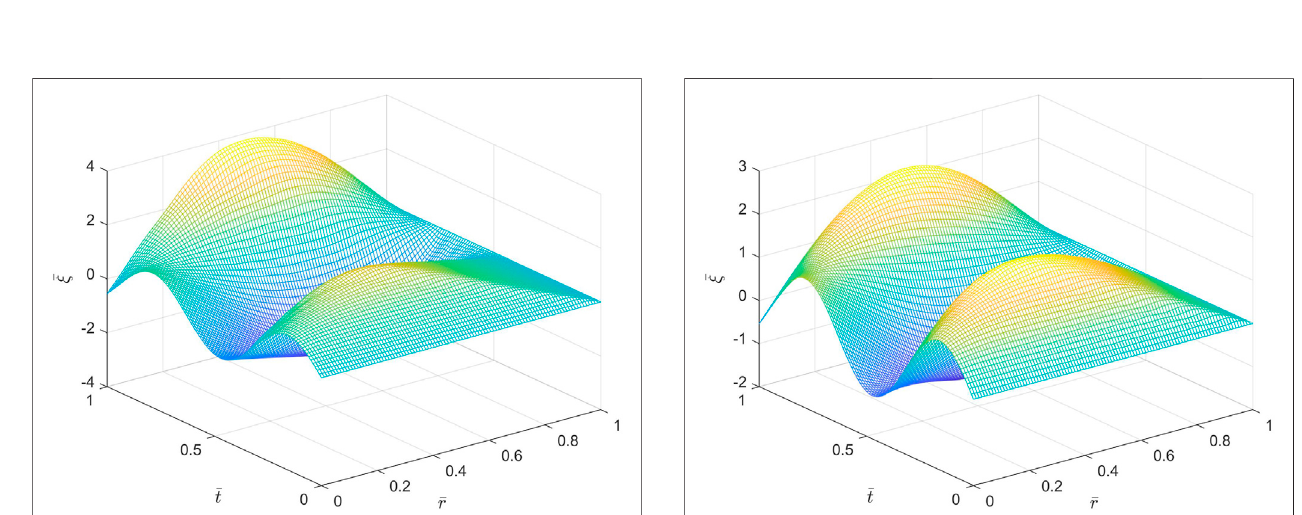
FIGURE 4 | Plots of the dimensionless axial displacement (cid:2) ξ versus the dimensionless time (cid:2) t at various dimensionless radial locations (cid:2) r within the vascular wall (A) r ― (cid:2) 0, (B) r ― (cid:2) 0.09, (C) r ― (cid:2) 0.24, (D) r ― (cid:2) 0.49, (E) r ― (cid:2) 0.74, and (F) r ― (cid:2) − 0.94 and for various constant values of α ∈ ( 0 , 1 ) .